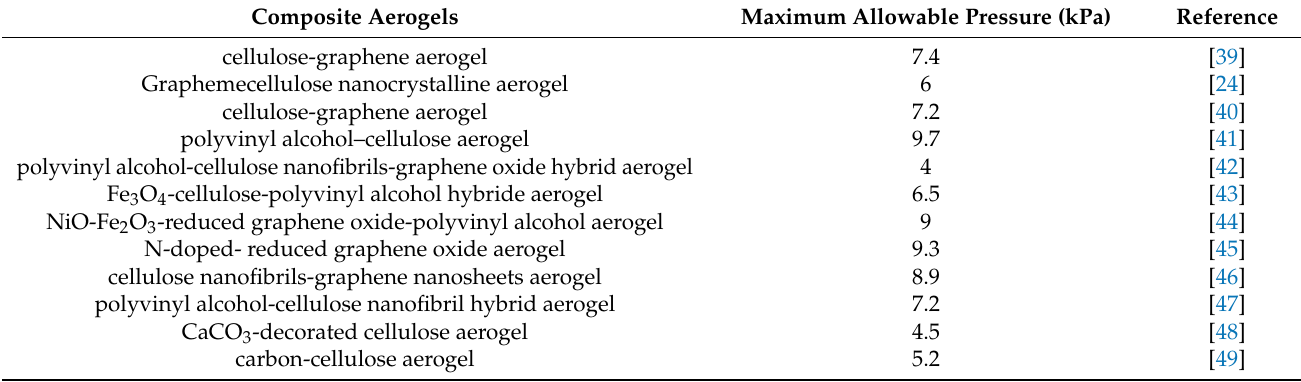
Table 1. Maximum pressure of CNF composite aerogel, GA composite aerogel and PVA composite aerogel.